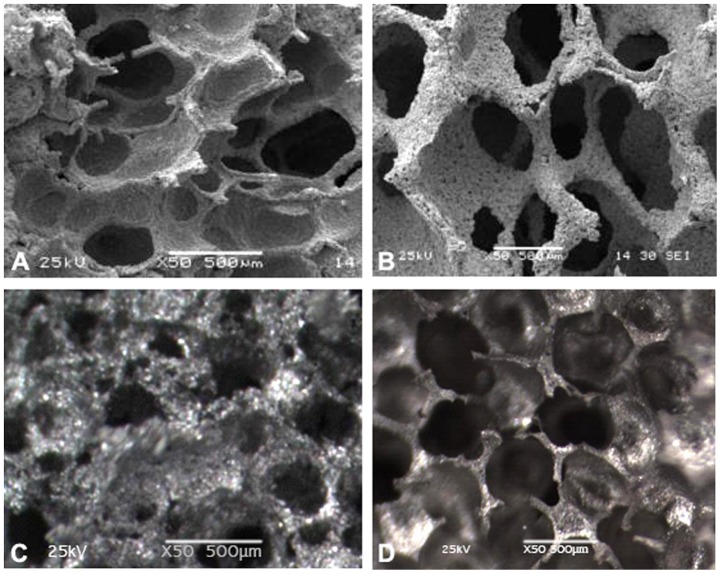
Pore size and porosity of Ti-25Nb alloy.(A)The titanium-niobium alloy formed porous shape with a rough surface, and its pores extended to the internal with a diameter of about 200–500 µm. (B) The pores interconnected with each other. (C) The pore of titanium-niobium alloy with 40% porosity showed maldistribution (D) The pore of titanium-niobium alloy with 70% porosity showed honeycomb shape, among which also presented part of fractures and connectivity.